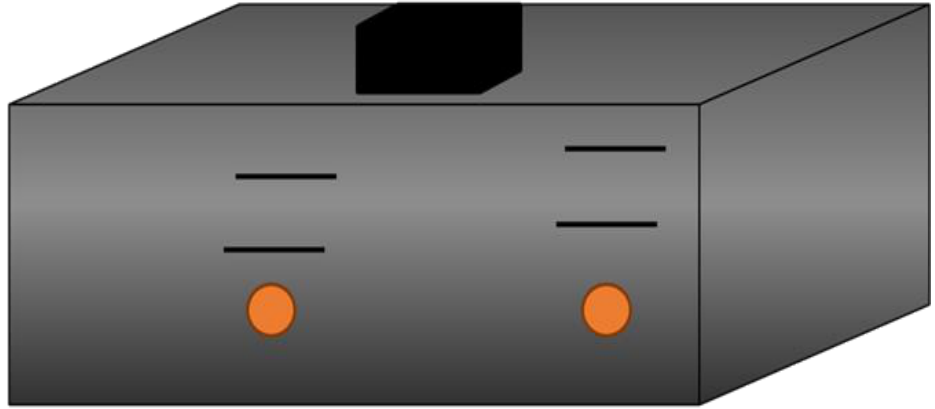
Figure 1. Basic setup of an impurity pair of atoms embedded in a semiconductor.